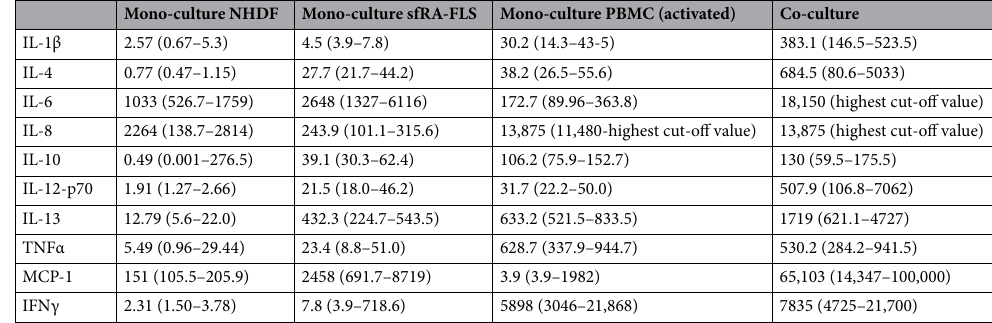
Table 1. Cytokine and MCP-1 production (pg/mL) by NHDF (n = 3–5), sfRA-FLS (n = 5) and CD3 and CD28 activated PBMC (n = 5) in mono-culture and by sfRA-FLS and activated PBMC in co-culture (n = 5). Data represented as median with 25–75% percentile. IL, interleukin; TNF, tumor necrosis factor; MCP-1, monocyte chemoattractant protein 1; IFN, interferon; sfRA-FLS, Synovial-fluid derived fibroblast-like synoviocytes, PBMC, peripheral blood mononuclear cells; NHDF, normal human dermal fibroblasts. ND = not